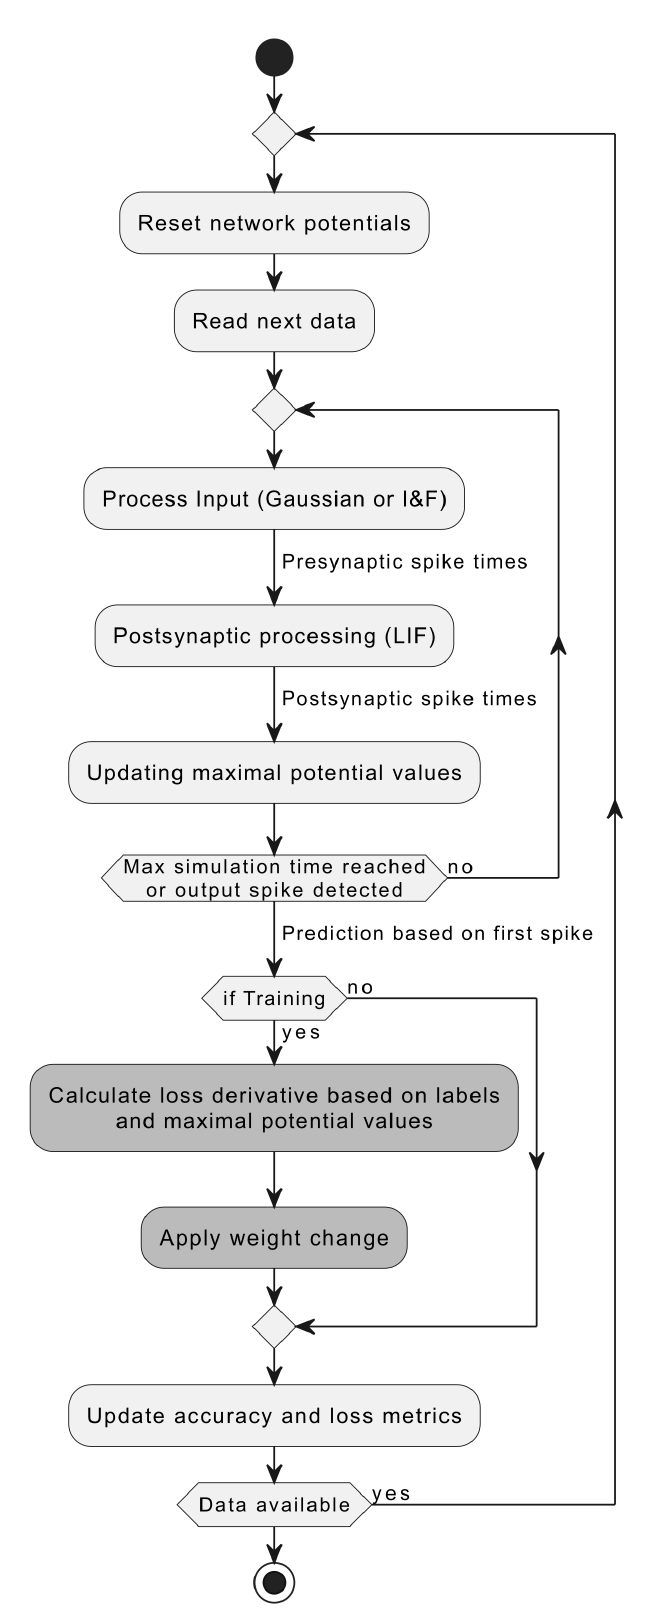
Figure 4. Training and inference process of simulated Tempotron SNNs. The steps enhanced by Caputron are denoted by dark gray